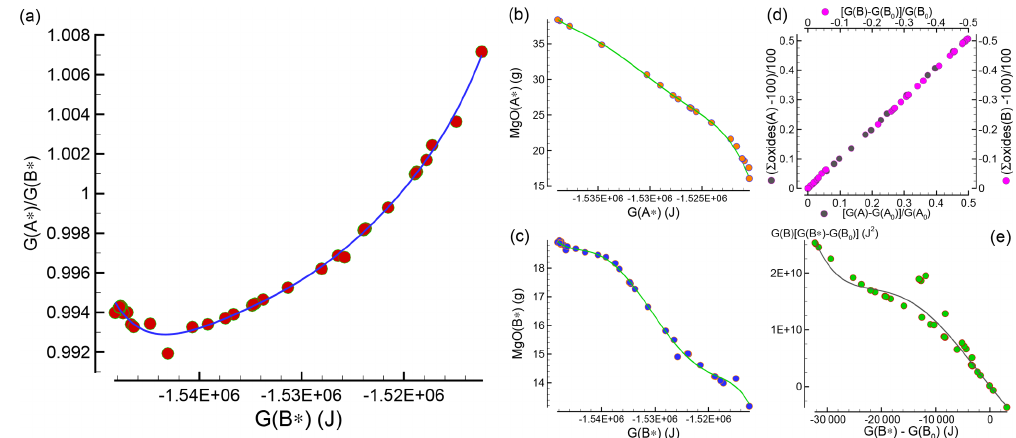
Figure 1. Data and relative fitting of 43 study cases that are used to develop the chemical equilibration model. (a) Relation between the ratio G(A ∗ )/G(B ∗ ) and G(B ∗ ) , which is applied to constrain G(A ∗ ) and G(B ∗ ) at the interface. Panels (b) and (c) illustrate the relation between G(A ∗ ) and G(B ∗ ) with MgO bulk abundance. Similar relations are applied for all nine oxides defining the bulk composition. The normalized bulk abundance is intended as grams with respect to a total mass of 100g, which is equivalent to weight percent. Knowing G(B) , the total size of the assemblage at equilibrium can be found assuming that (1) a relation between the mass change and the change in G(B) is established (d) . (2) The extension of the assemblage is proportional to the mass change and it takes place along a direction perpendicular to the interface. The total length at equilibrium is then adjusted in accordance with the difference between the spatial average G(B ∗ ) of the assemblage and G(B ∗ ) at the interface (see the main text for a detailed explanation). The change in size of the second assemblage is also applied on the first assemblage but with opposite sign. Panel (e) allows for the determination of G(B) from the relation with G(B ∗ ) at the